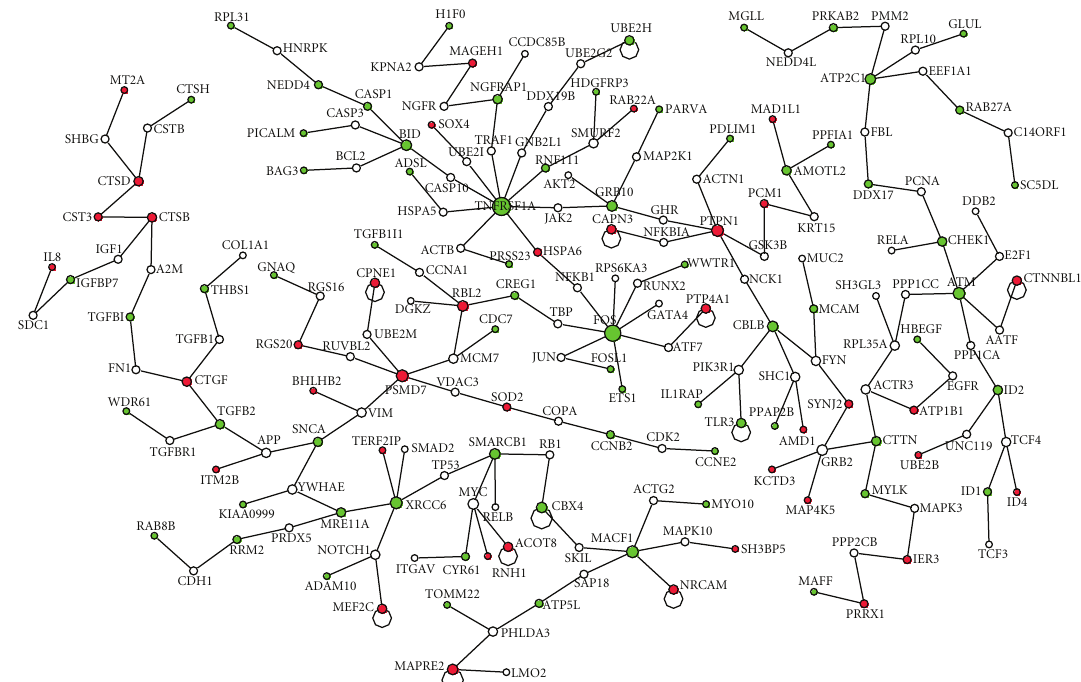
Figure 2: The minimum spanning tree of the network associated with cancer pathway genes. The backbone of the tree is shown. Up-and down regulated genes are shown in red and green